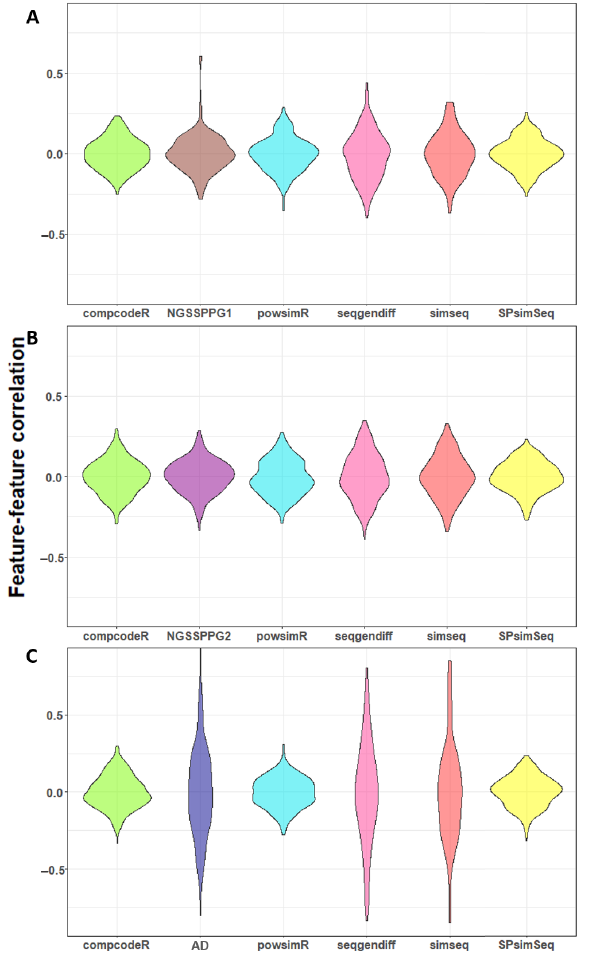
Figure 6. Feature-feature correlation plots of the ( A ) NGSSPPG1; ( B ) NGSSPPG2; and ( C ) AD data and the datasets generated with these as